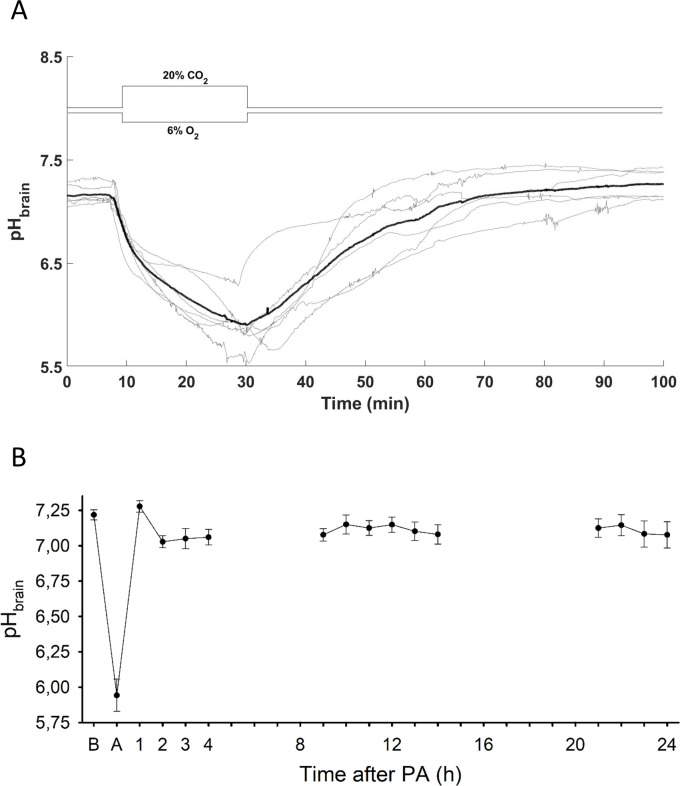
pHbrain changes during PA and the reventilation period.(A) pHbrain changes (grey lines–individual tracings, bold black line–mean) are plotted 10 min prior the onset asphyxia, during asphyxia, and the first hour of reventilation. pHbrain fell progressively during asphyxia showing severe cerebrocortical acidosis, by the end of the insult the pH drop exceeded 1.0 pH unit virtually in all asphyxiated animals. Reventilation quickly restored pHbrain to baseline levels. (B) pHbrain alterations upon PA and over the 24-hour period after PA: after recovery from the PA-induced severe acidosis, no further significant pHbrain alterations were detected at the selected time intervals (n = 6 at PA and between 1–4 hours; n = 8 between 8–14 hours and n = 3 between 20–24 hours; respectively). B: baseline, A: at the end of 20 minute PA. Panel B data points are presented as mean±SEM. *p<0.05 vs. baseline.